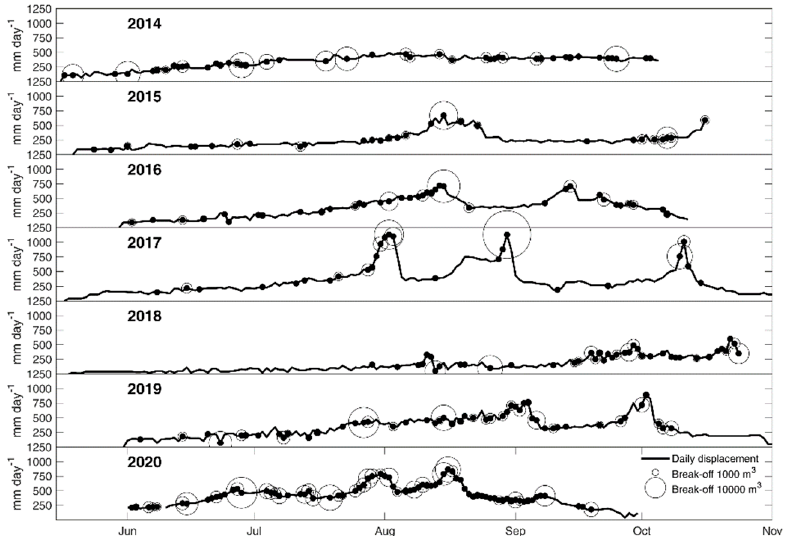
Figure 5. DIC time series of the daily velocity of the ML snout. The solid black circles represent the break ‐ offs, while the white circle size is proportional to the break ‐ off volume. Modified from [37].